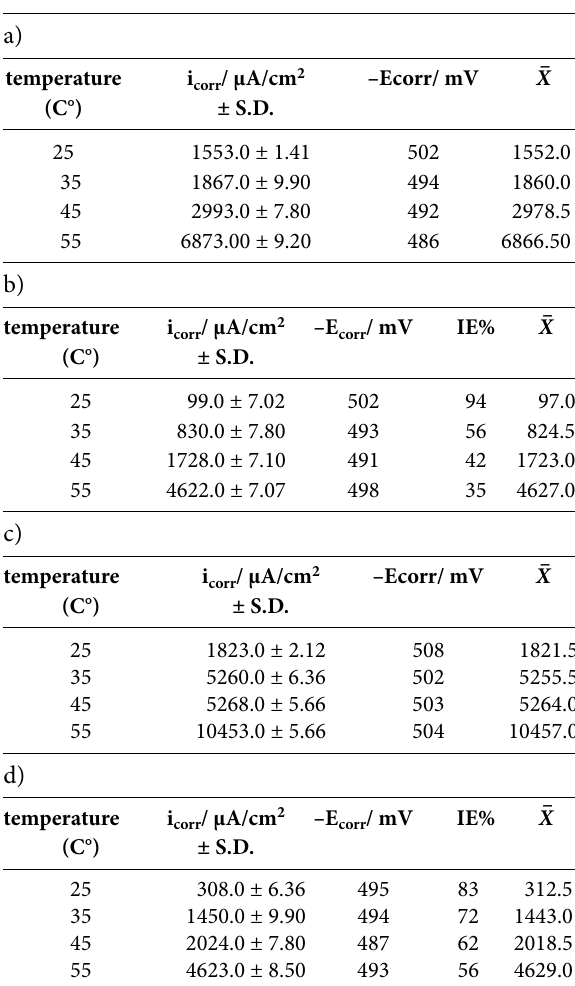
Table 3. Corrosion parameters calculated from polarization meas- urements in 1 M hydrochloric acid a) without inhibitor b) with 300 ppm of inhibitor and sulfuric acid solution c) without inhibitor d) with 300 ppm of inhibitor, at different temperatures. (Results de- rived from at least two repeats of experiment.)